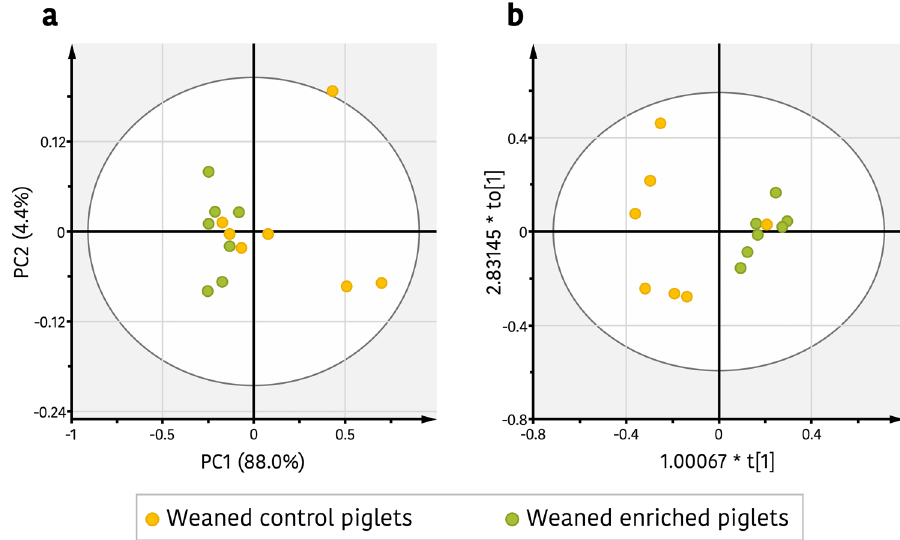
Figure 2. Effect of environmental and social enrichment on the serum metabolic profiles of piglets. ( a ) Principal components analysis (PCA) score plot of serum data set from weaned enriched (blue) and weaned control piglets (red). ( b ) Orthogonal partial least squares discrimination analysis (OPLS-DA) score plot between weaned enriched piglets (blue) and control group (red). Figure created by using open-source software R v3.5.3. (https ://www.r-proje ct.org/found ation /).